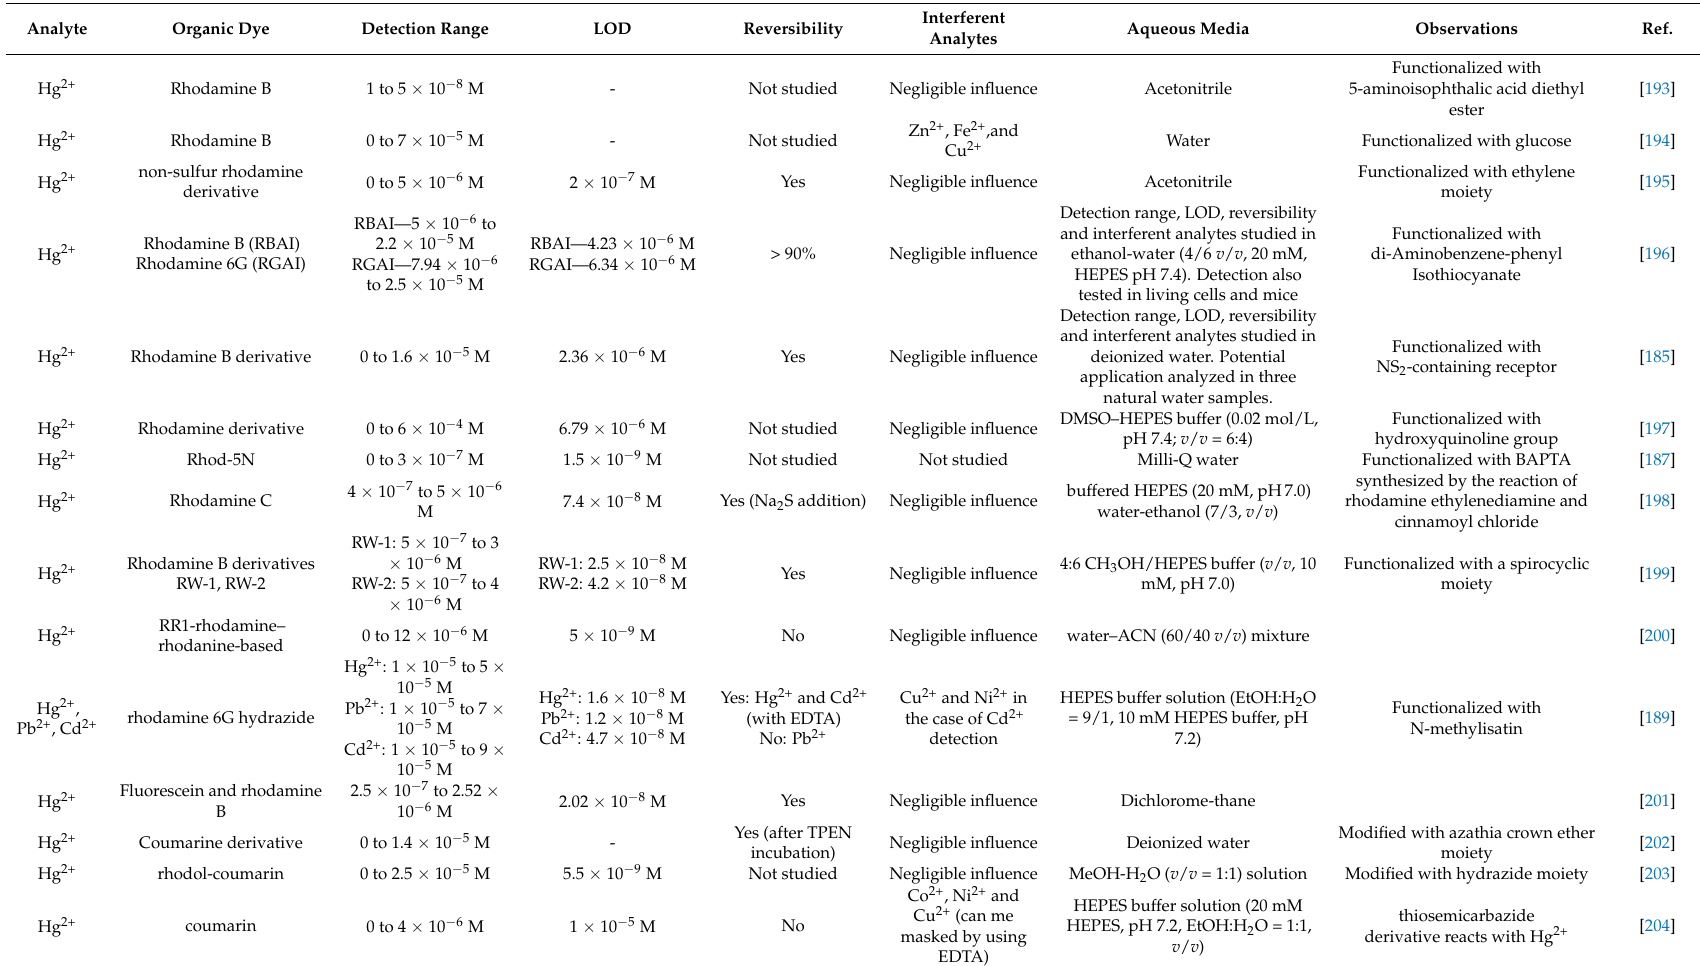
Table 5. Hg 2+ sensors for different metal ions based on organic